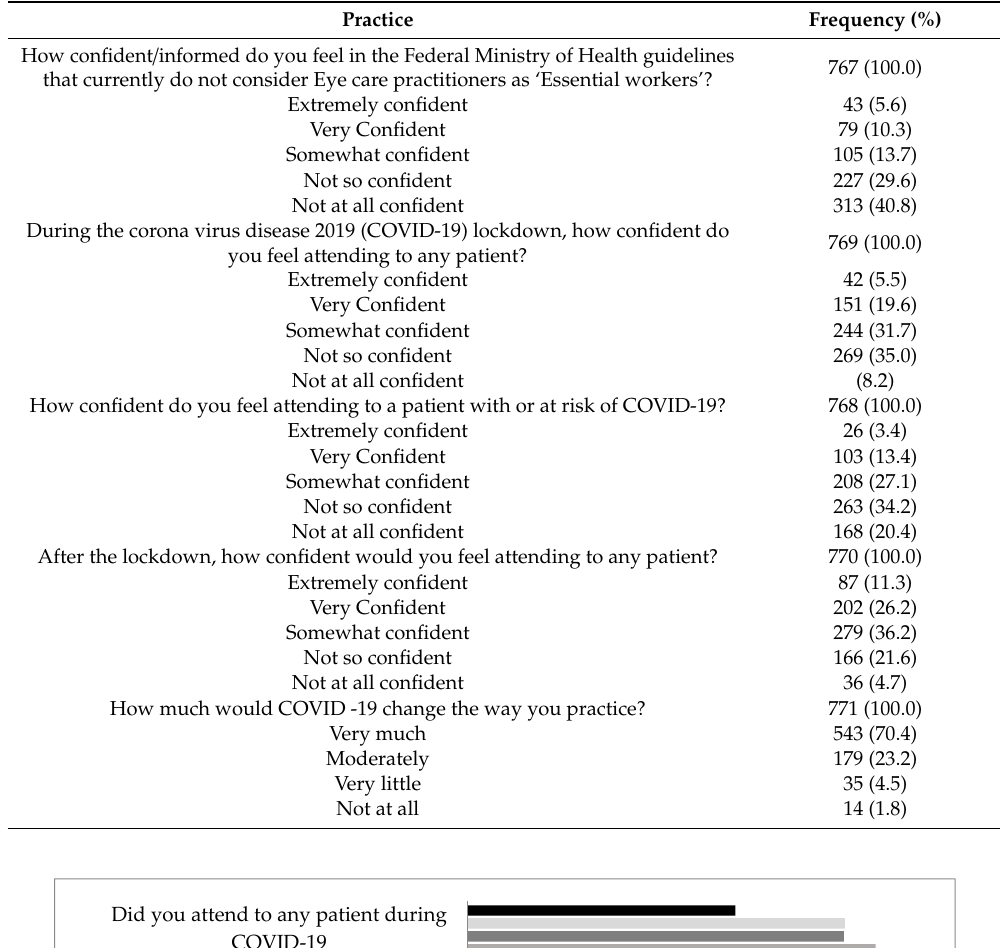
Table 4. Practice of respondents during the lockdown.